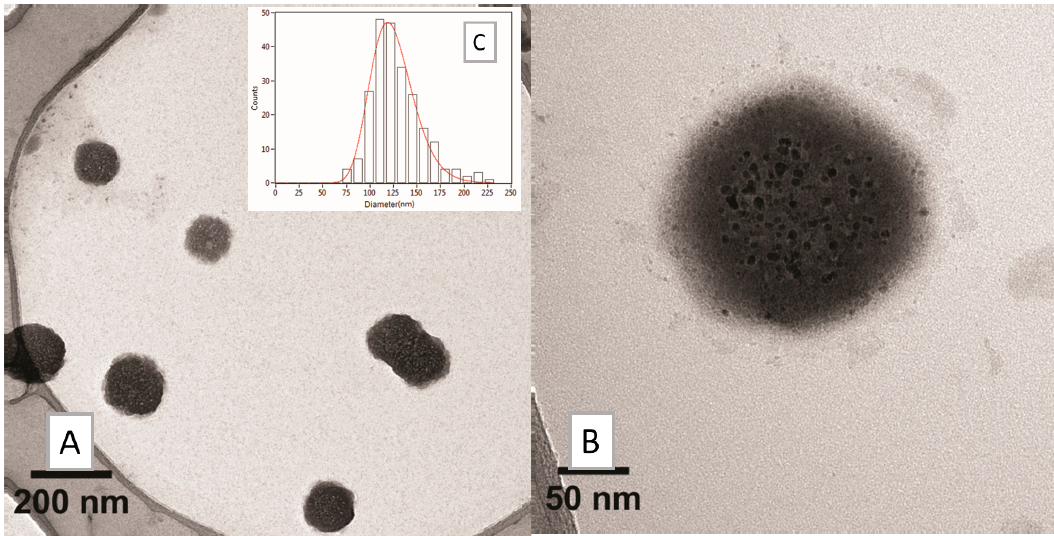
Figure 9. TEM analysis on SPION2: ( A ) low- and ( B ) high-magnification bright field micrographs and ( C ) size distribution histogram of the nanosystems.